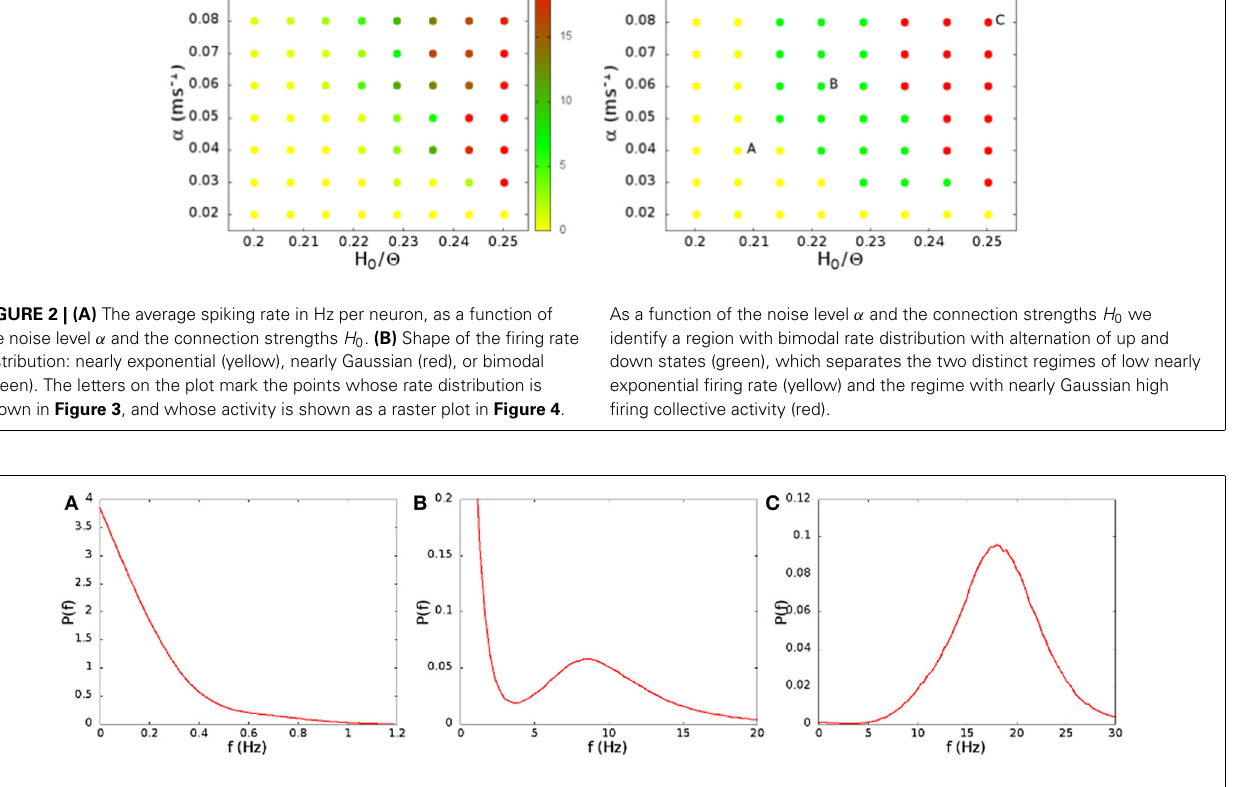
FIGURE 3 | Distribution of the spiking rates on time intervals of 1ms, for (A) H 0 /(cid:4) = 0 . 207, α = 0 . 04ms − 1 , (B) H 0 /(cid:4) = 0 . 221, α = 0 . 06ms − 1 , (C) H 0 /(cid:4) = 0 . 250, α = 0 . 08ms − 1 . These parameters correspond to the points marked with the letters A, B, and C in Figure 2B